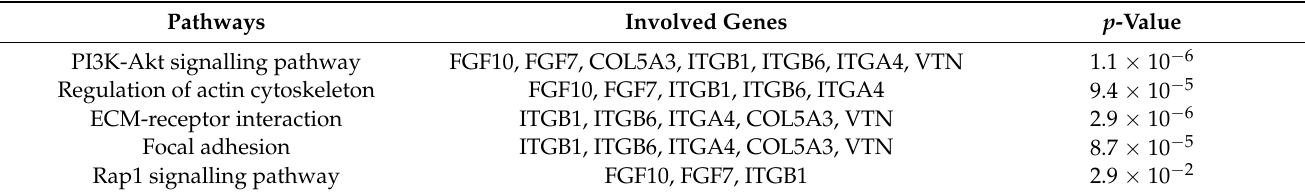
Figure 8. Fold changes in the DEGs expressed after KMST-6 cells were treated with C. orbiculata water extract. Genes with a fold change of ≥± 1.5 and p-values of <0.05 were considered as DEGs. Table 3. Enriched pathways in which C. orbiculata water extract expressed DEGs function